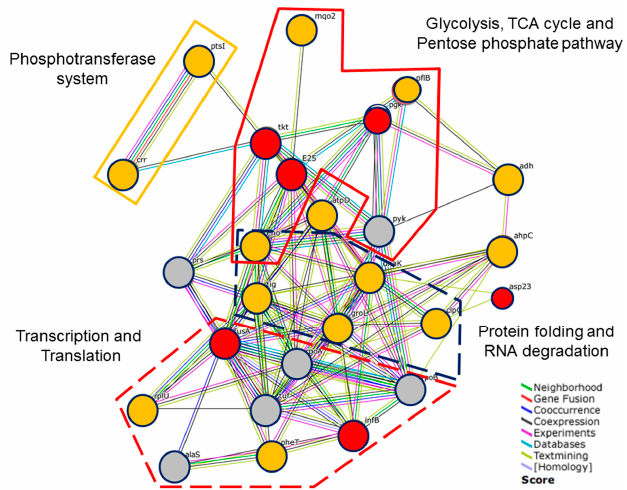
Figure 4. Differentially expressed proteins of ursolic acid–treated MRSA compared with controls. Dots in different colors represent repressed (red), induced (yellow) or no change (gray) in the presence of ursolic acid by quantitative proteomics. The identified proteins were classified by the annotation system Database for Annotation, Visualization and Integrated Discovery (DAVID) (version 6.7). The lines represent putative protein interactions recorded or predicted by STRING (version 10.0).